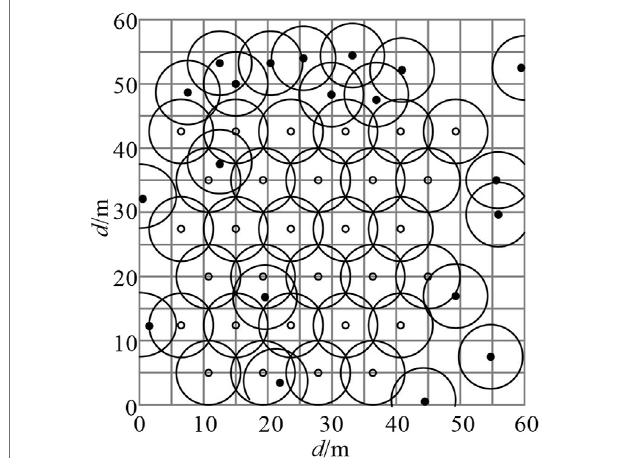
FIGURE 6 | Recovery after rule